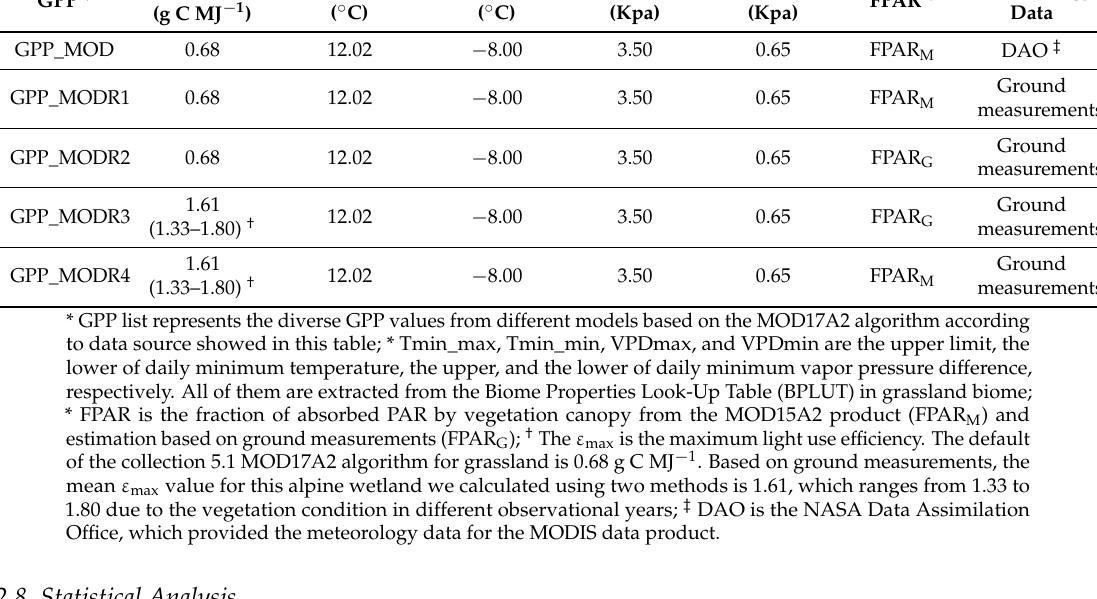
Table 1. Parameterization schemes for estimating gross primary production (GPP) in this alpine wetland based on the MOD17A2 algorithm.